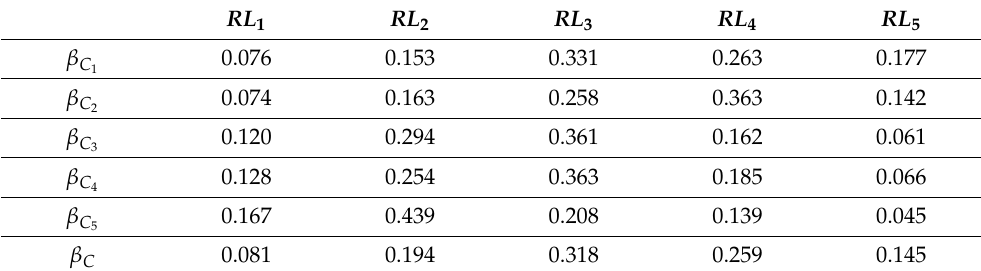
Table 13. Results of fuzzy intersection reliability assignment of risk indicators. RL 1 RL 2 RL 3 RL 4 RL 5 β C 0.076 1